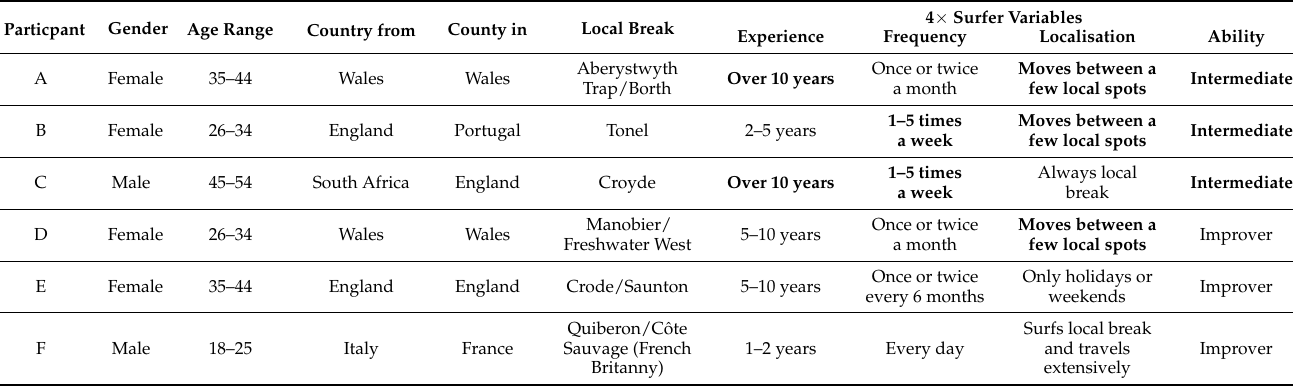
Table A2. Demographics of chosen participants. The highest frequencies of surfer variables found in the survey results are in